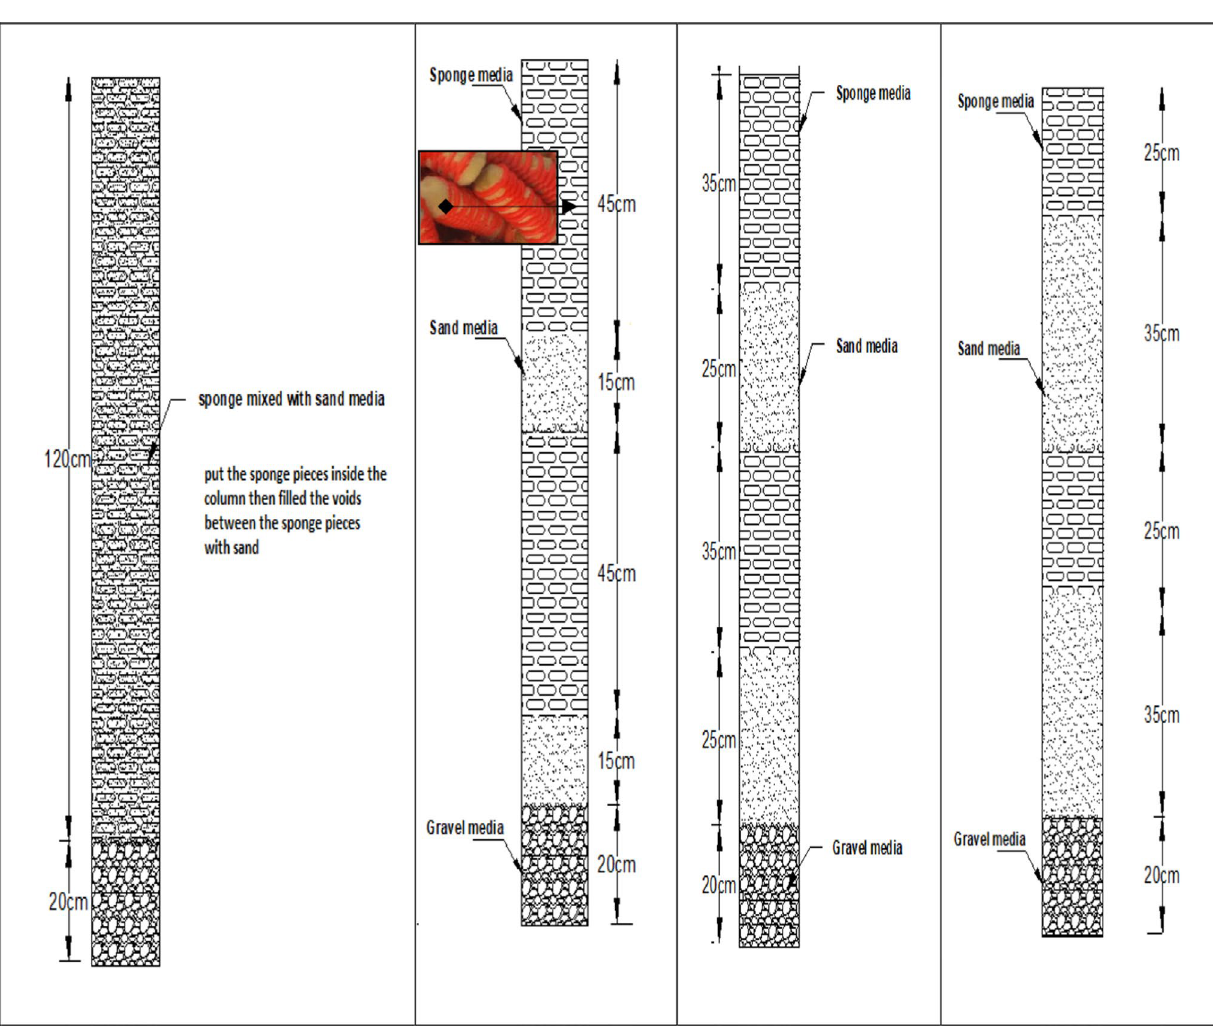
Fig. 10 The experimental setup for run (2) for the best efficiency mixing ratio Column (1): the percentage of the sponge in the mixing ratio was 46%, so the mixing ratio of sand/sponge was 1:0.85 with respect to volume. Column (2): the percentage of the sponge in the mixing ratio was 34%, so the mixing ratio of sand/sponge was 1:0.5